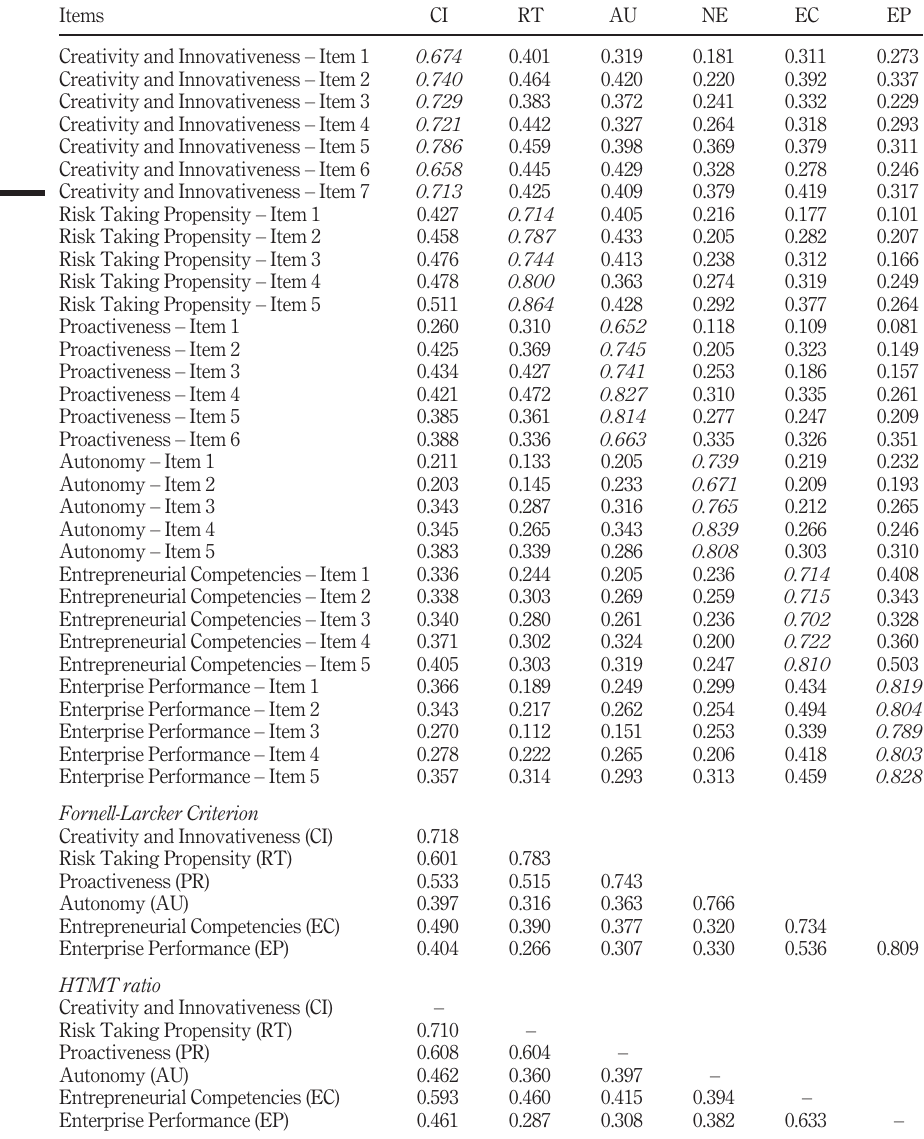
Table III. Loadings and Cross-